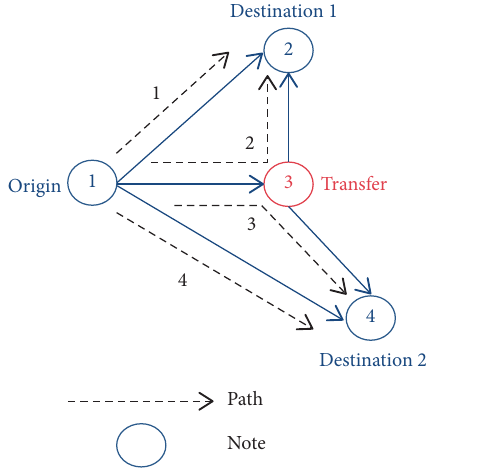
Figure 1: Illustration of the physical urban rail network.